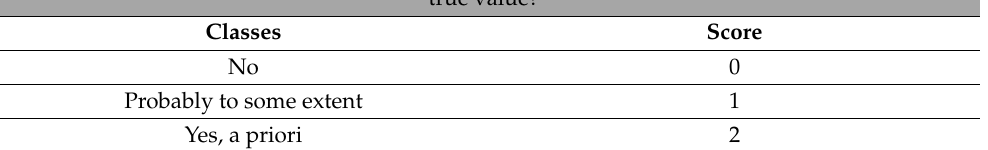
Table 5. Ac sr,pa